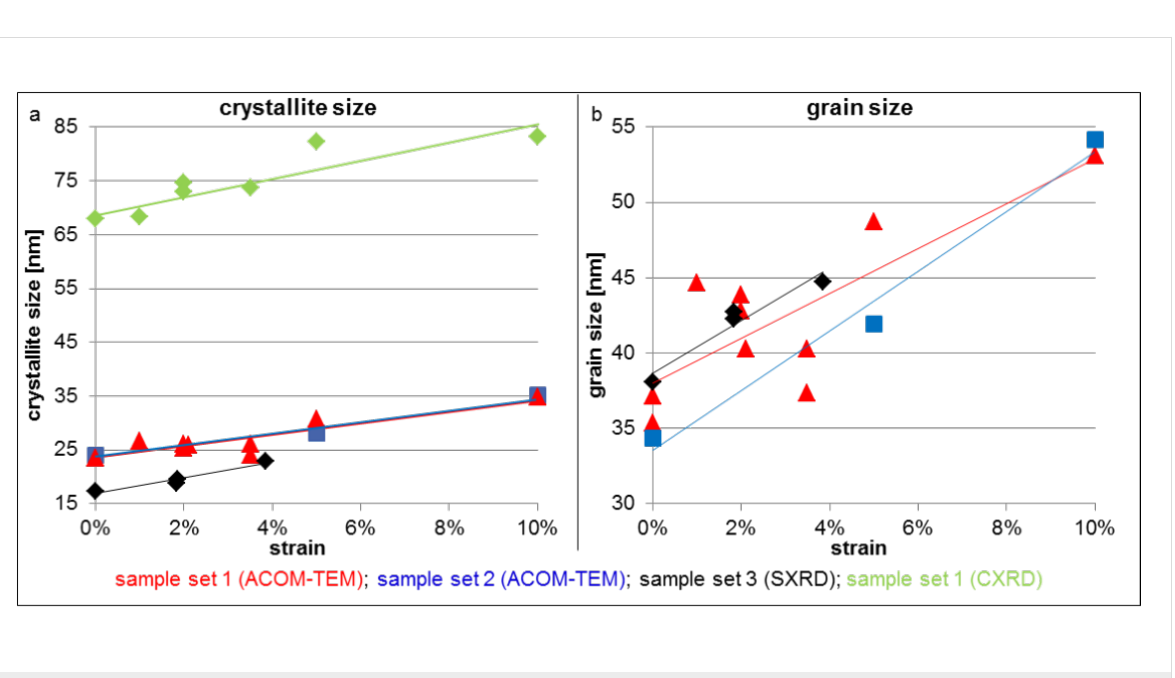
Figure 5: a) Crystallite and b) grain size as a function of strain based on ACOM-TEM (equivalent in-plane diameter) (ncPd 1: red, ncPd 2: blue), CXRD (out-of-plane grain size) (ncPd 1: green) and in-situ SXRD (area weighted in-plane diameter) (ncPd 3: black)